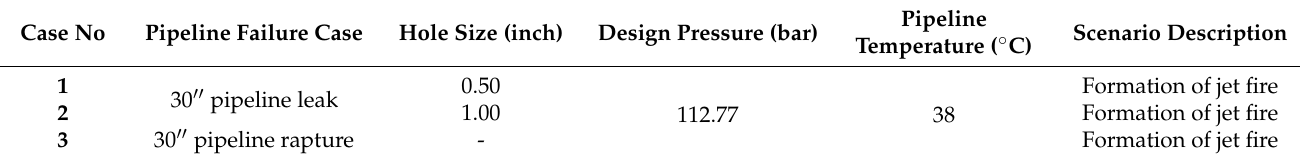
Table 8. Hypothetical Failure Cases for Modeling the